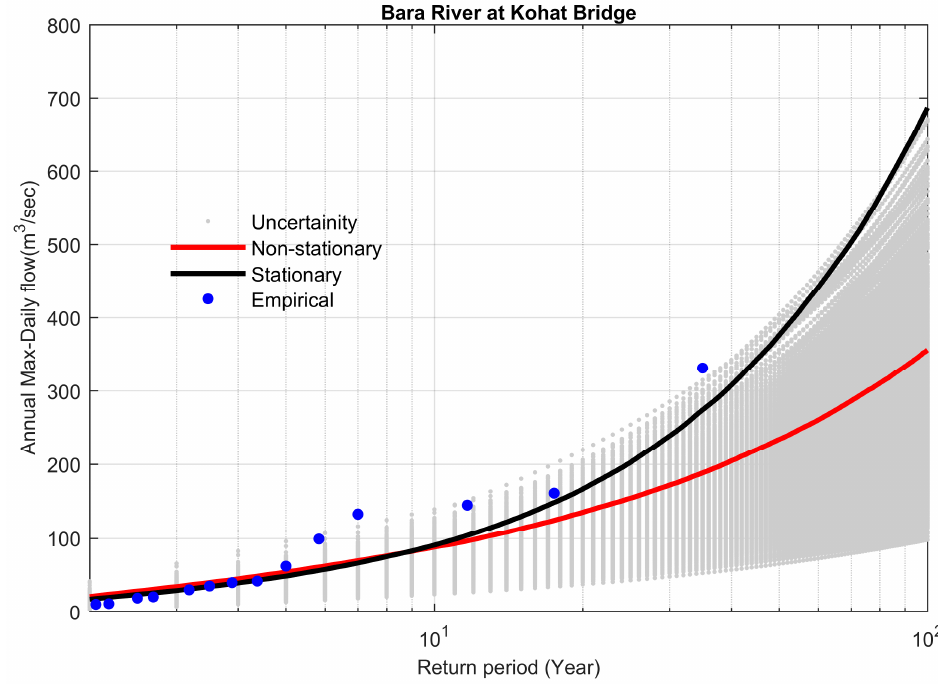
Figure 8. Comparison between non-stationary and stationary FFCs at site 24, along with non-stationary uncertainty bounds for the year 2016.